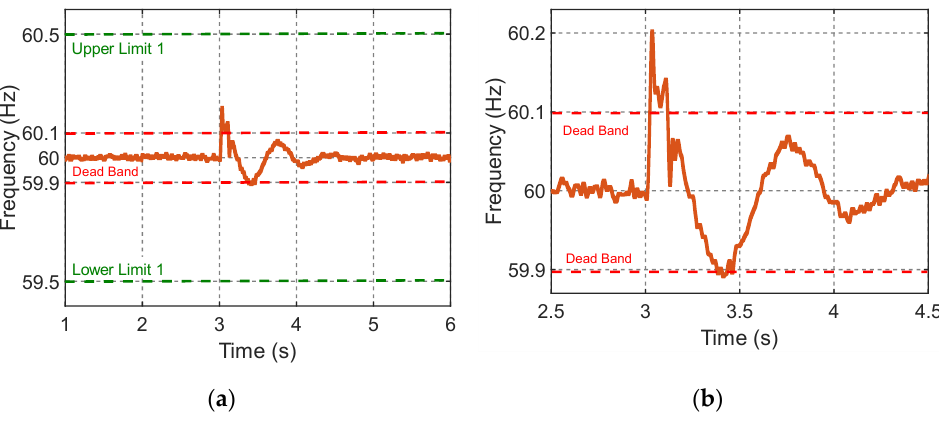
Figure 15. Scenario 2, system ’ s frequency: ( a ) frequency; ( b ) frequency